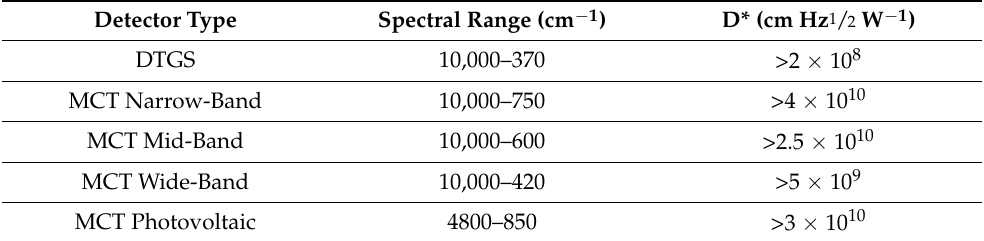
Table 2. Comparison of detectors of different areas basing on their D* values.